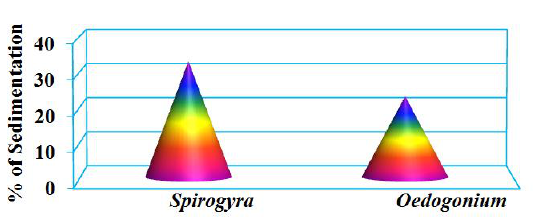
Figure 7. Sediments after algal biodiesel extraction from Oedgonium sp. and